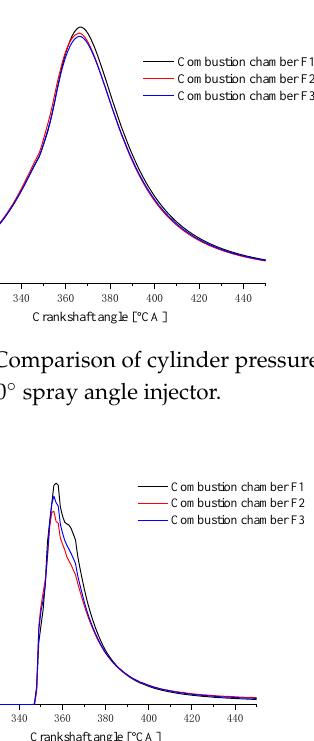
Figure 17. Comparison of the instantaneous heat release rate curves of the three combustion chamber schemes matched with the 160° spray angle injector.